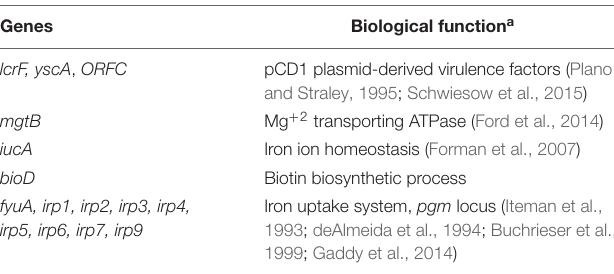
TABLE 2 | Biological functions of the candidate